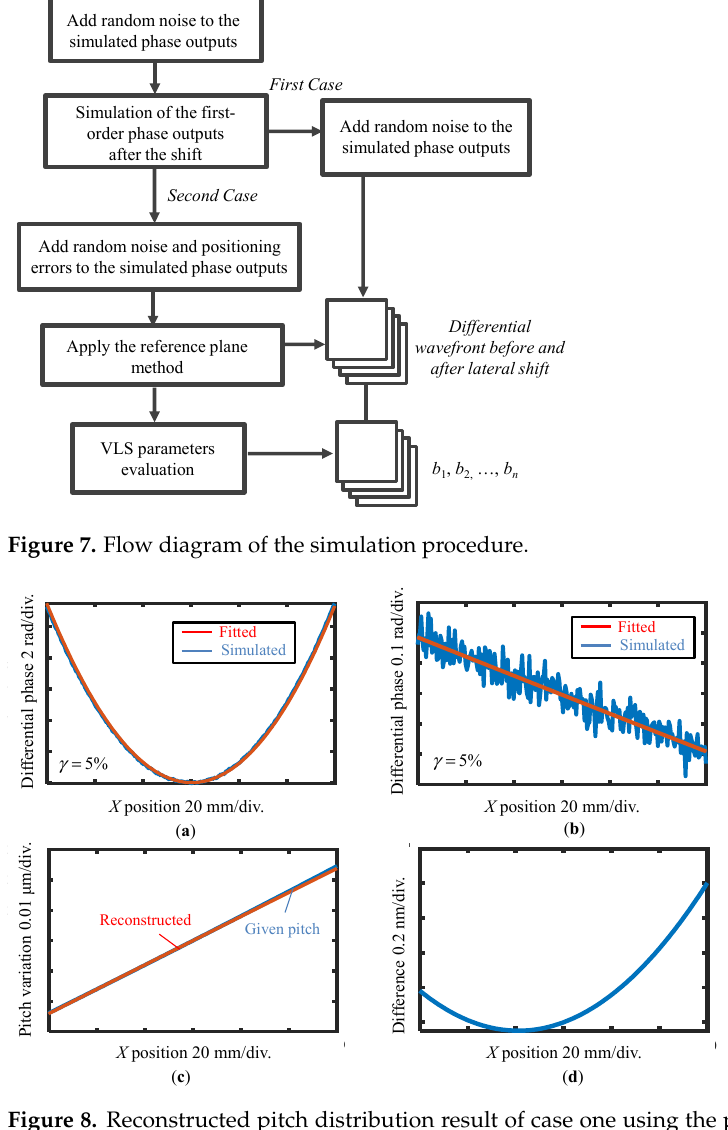
Figure 8. Reconstructed pitch distribution result of case one using the proposed method without applying the reference plane technique. ( a ) Evaluated differential phase outputs and its fitting result before the shift with 5% noise level; ( b ) Evaluated differential phase outputs and its fitting result after the shift with 5% noise level; ( c ) Given pitch in simulation and reconstructed pitch variation of VLS grating; ( d ) Difference between the simulation and the reconstruction result.